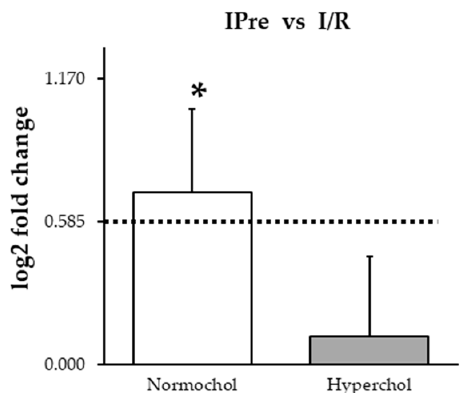
Figure 3. miR-125b-1-3p expression changes induced by ischemic preconditioning (IPre) in hearts of normocholesterolemic and hypercholesterolemic rats. Values are log2 expression changes ± SEM calculated with Deseq2. * p < 0.05 and log2 fold change is greater than 0.585 vs. corresponding ischemia/reperfusion (I/R) control group. Normochol and Hyperchol refer to normo- and hypercholesterolemia, respectively.